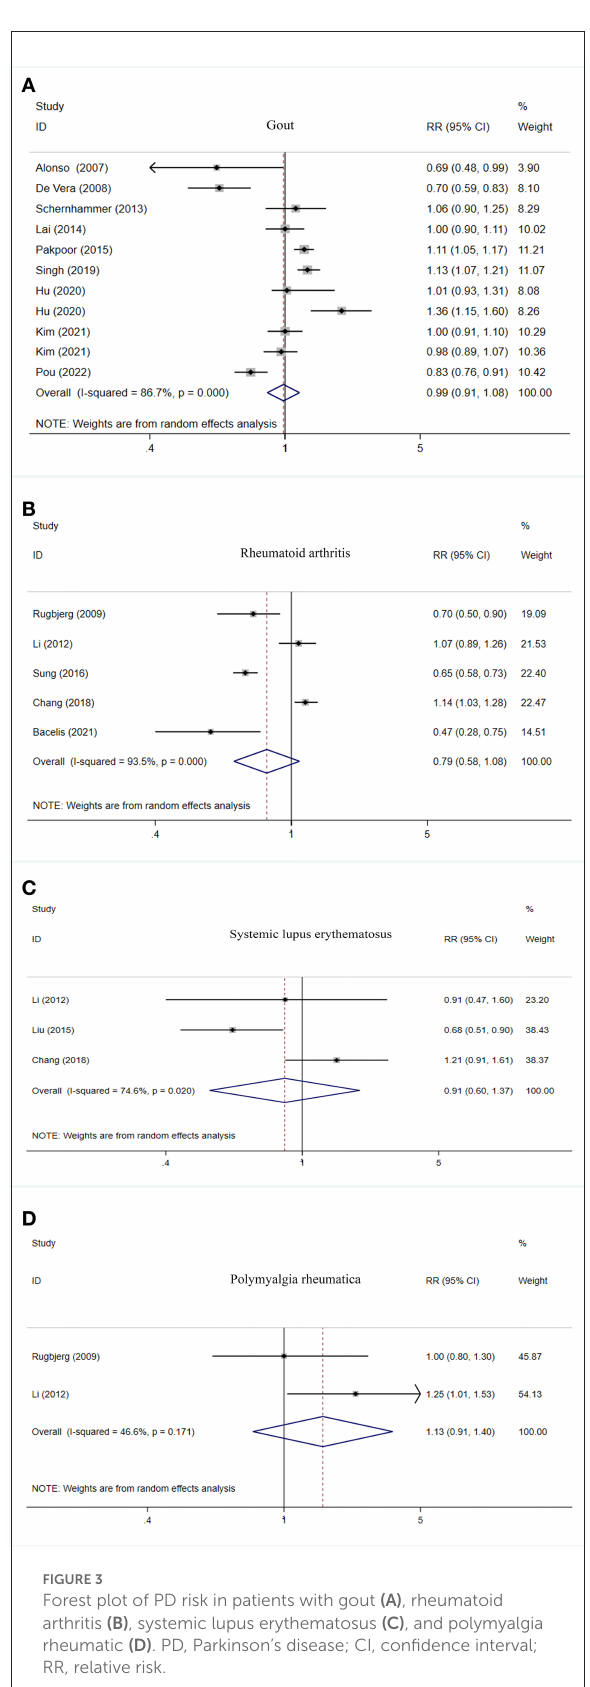
FIGURE3 Forest plot of PD risk in patients with gout (A) , rheumatoid arthritis (B) , systemic lupus erythematosus (C) , and polymyalgia rheumatic (D) . PD, Parkinson’s disease; CI, confidence interval; RR, relative